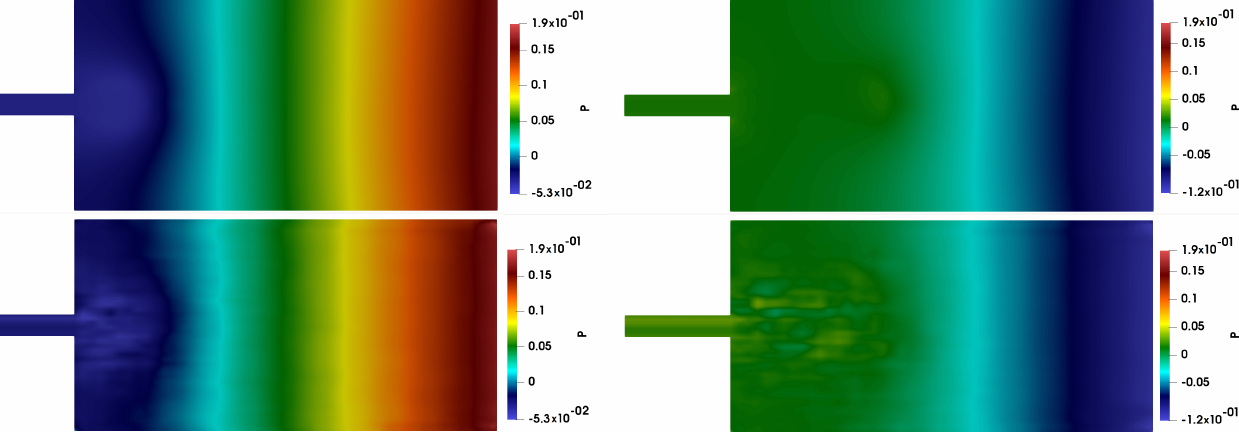
Figure 11. (Data-targeted VAE) On the top, the high-fidelity pressure of the velocity fields for the two time steps 499 and 998. On the bottom, the decoder outputs for the two time steps 499 and 998 at the final 4000-th epoch of the training